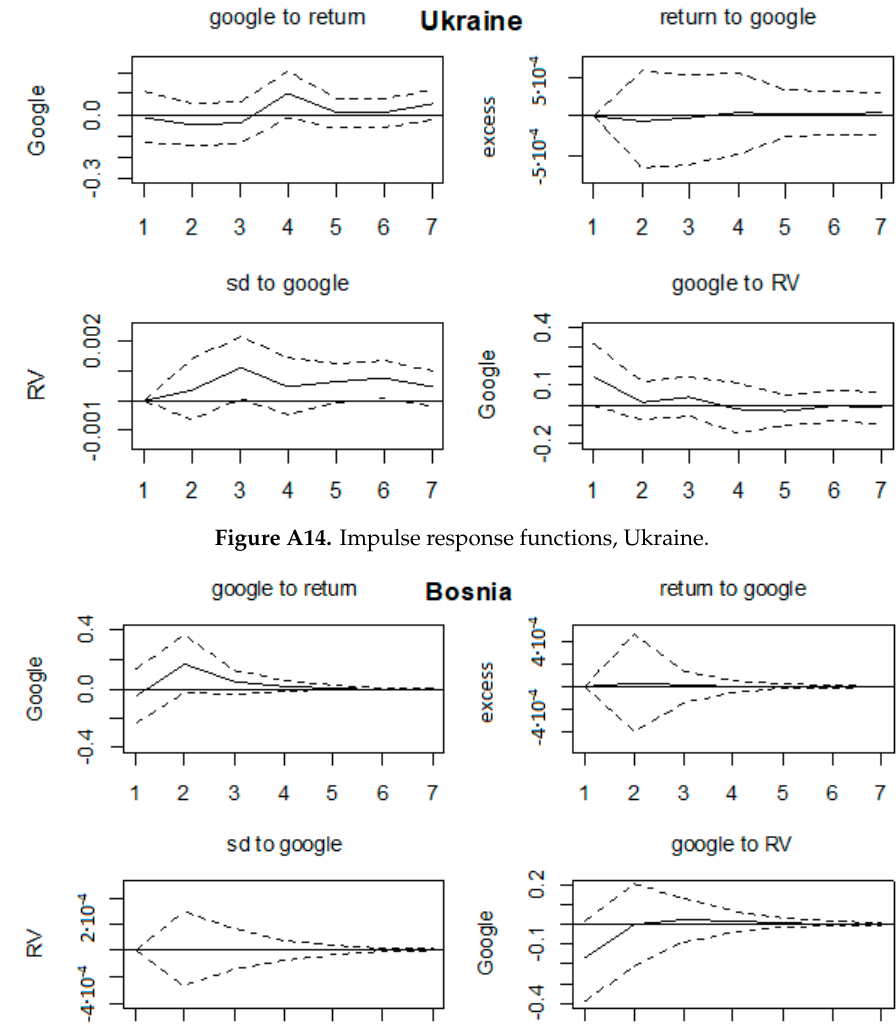
Figure A15. Impulse response functions, Bosnia and Herzegovina.